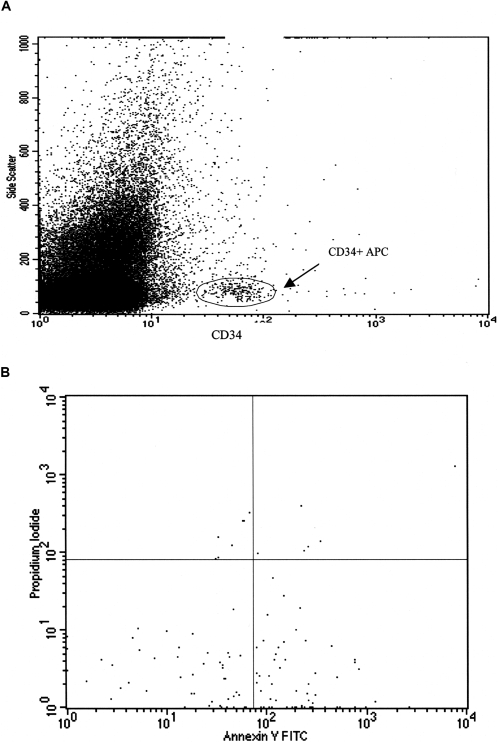
Representative flow cytometric dot plots: SSC/CD34 scatter (1a) and flow cytometric evaluation of progenitor CD34+ apoptotic cell percentage (1b).Dots in the lower right quadrant represent early apoptotic cells (Annexin-V positive and PI negative) while dots in the upper right quadrant represent late apoptotic cells (Annexin-V and PI positive).